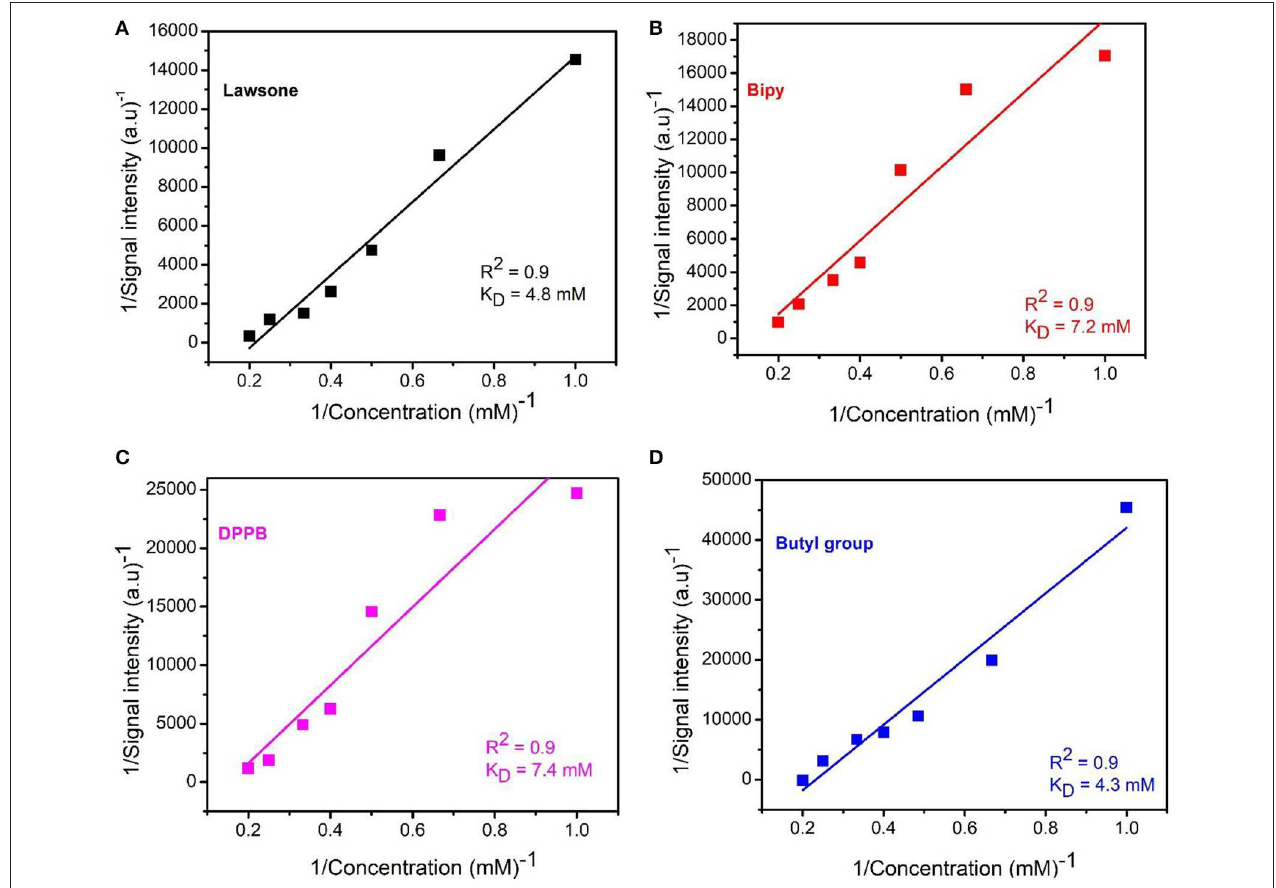
FIGURE 7 | Lineweaver-Burk plot for the experimental STD-NMR concentration experiments obtained for CBLAU and used to estimate the dissociation constant (K D ) for each group: lawsone (4.8mM) (A) , bipy (7.2 mM) (B) , DPPB (7.4mM) (C) and butyl group (4.3mM) (D) and the average K D value (5.9mM) for this molecule (CBLAU) in interaction to